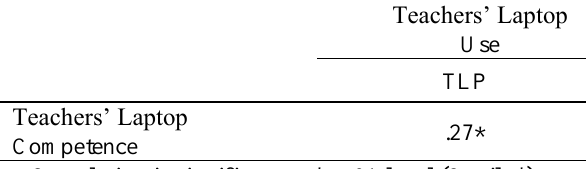
Table 12: Pearson Product-Moment Correlation between Teachers’ Laptop Competence and